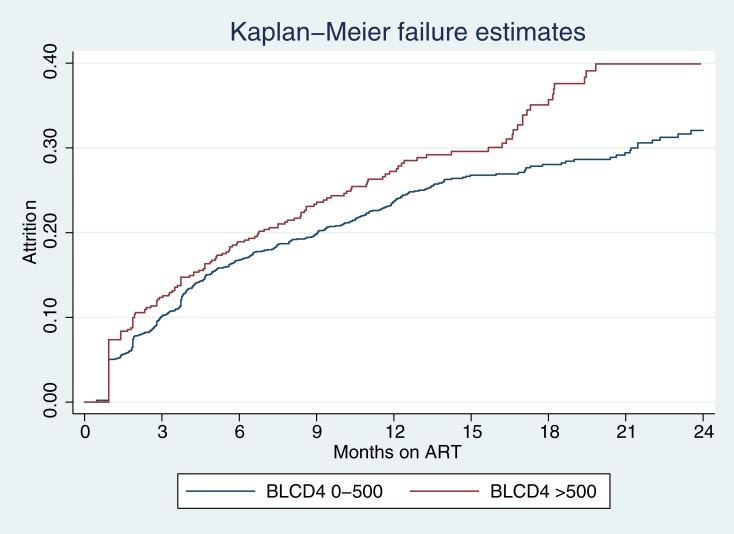
Kaplan Meir failure estimates for attrition stratified by baseline CD4 cell count.BLCD4: Baseline CD4 cell count in cells/μL. Log-rank test for equality of survivor functions: P = 0.02.